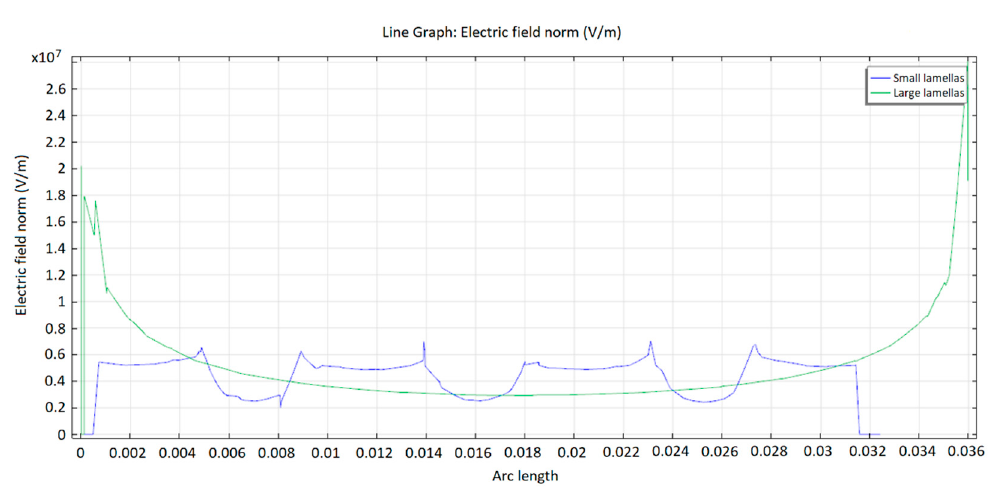
Figure 28. Results of the electric field distribution along the measurement lines.